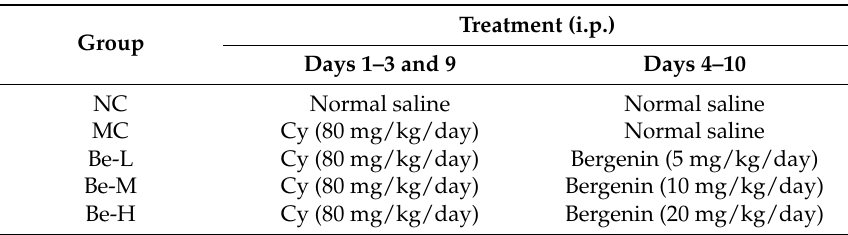
Table 1. Mouse treatment schedule. NC: normal control group, dosed with saline; MC: model control group, challenged with cyclophosphamide; Be-L: challenged with Cy and treated with 5 mg/kg/day bergenin; Be-M: challenged with Cy and treated with 10 mg/kg/day bergenin; Be-H: challenged with Cy and treated with 20 mg/kg/day